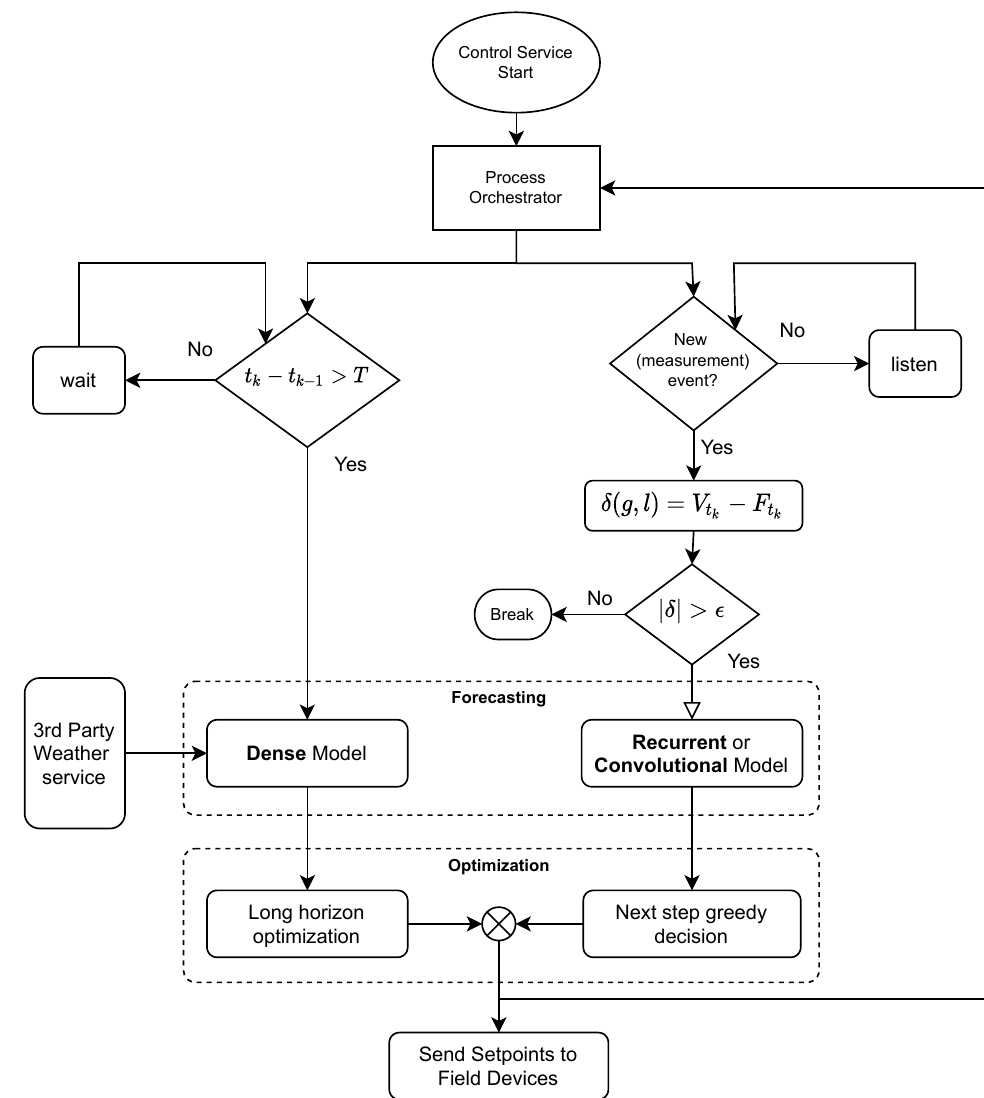
Figure 2 represents the control process of the full control chain, schematically.